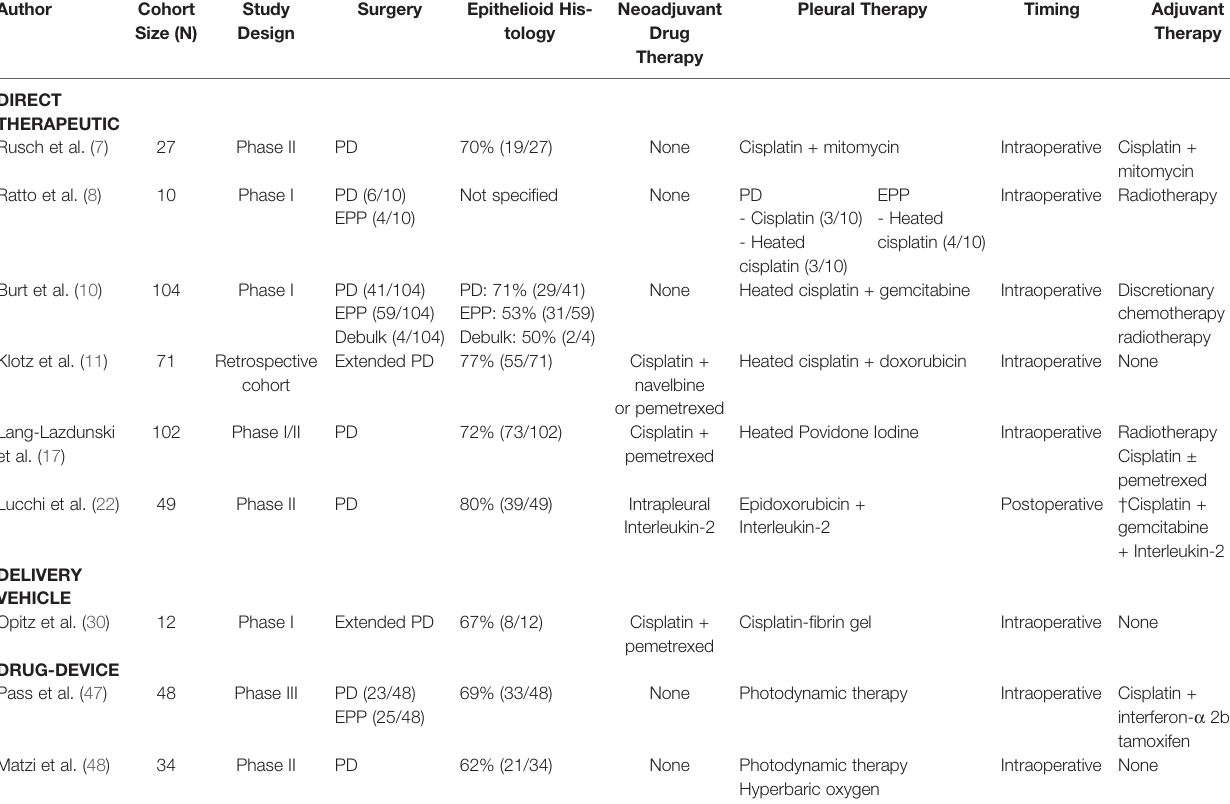
TABLE 2 | Diverse mesothelioma treatment studies with a component of Intrapleural